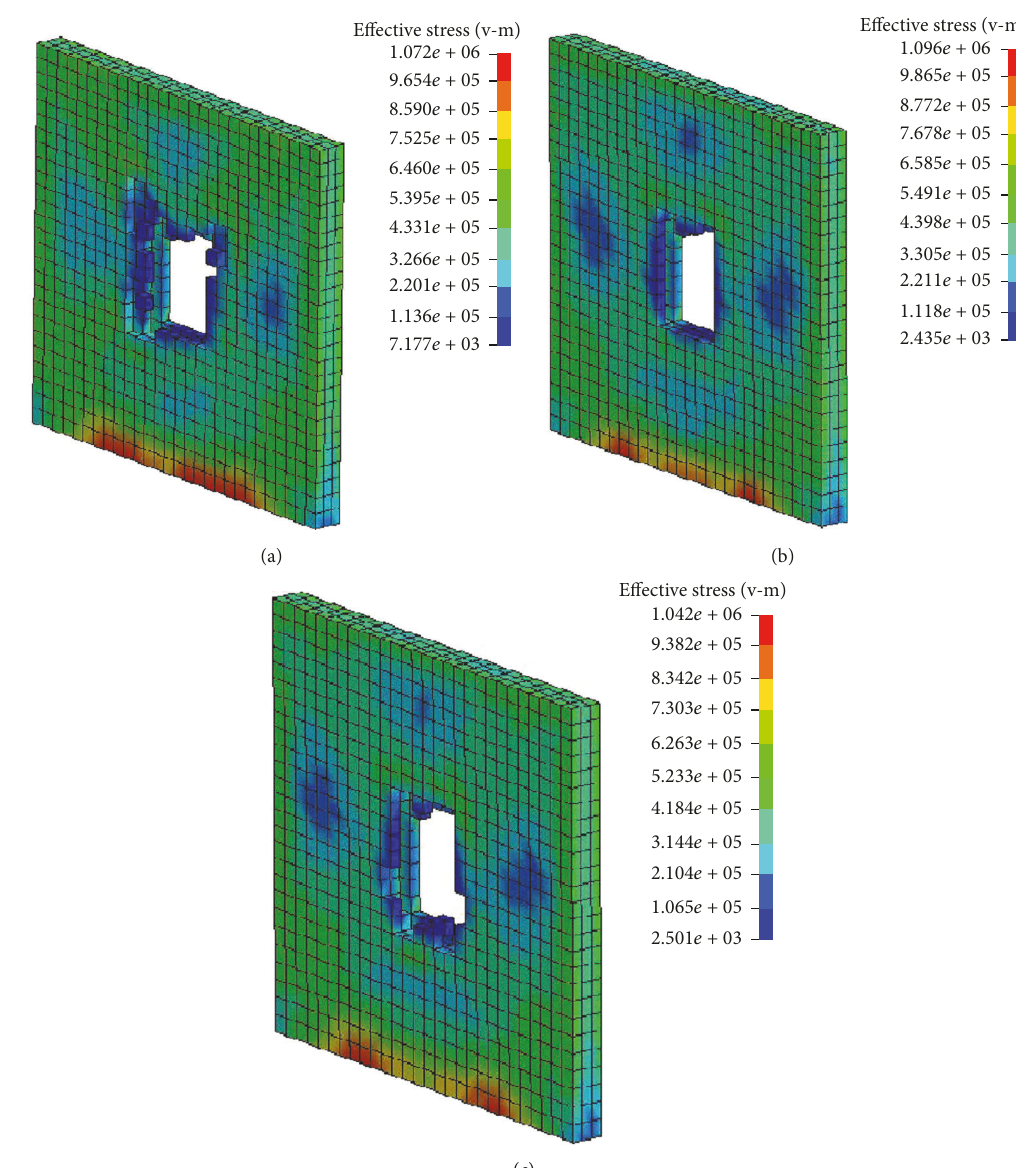
Figure 17: Stress contours of impacted wall at 𝑇 = 300 ms: (a) model 7, (b) model 8, and (c) model 9.